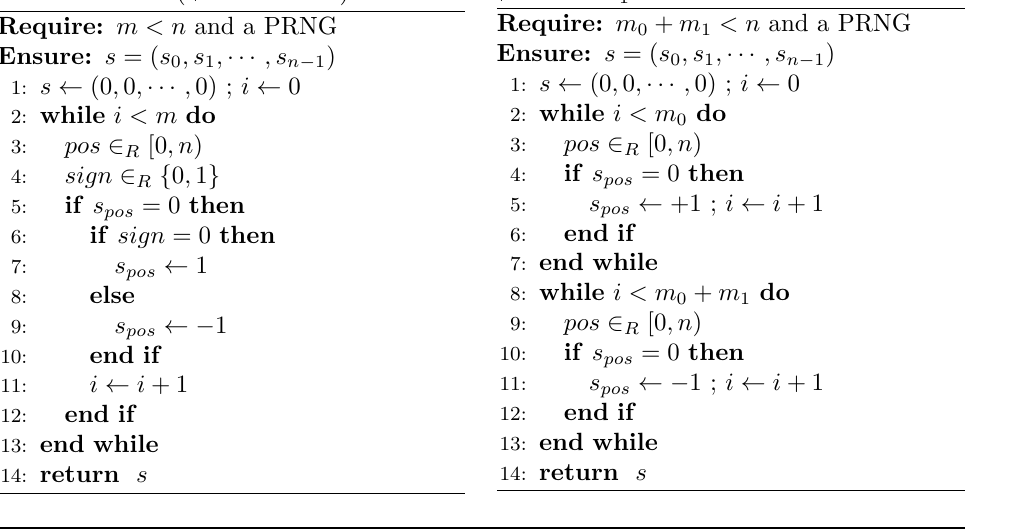
Algorithm 11 Trinary Sampling with coefficients from {− 1 , 0 , +1 } distributed according to Pr( x = 1) = Pr( x = − 1) = ρ/ 2 and Pr( x = 0) = 1 −